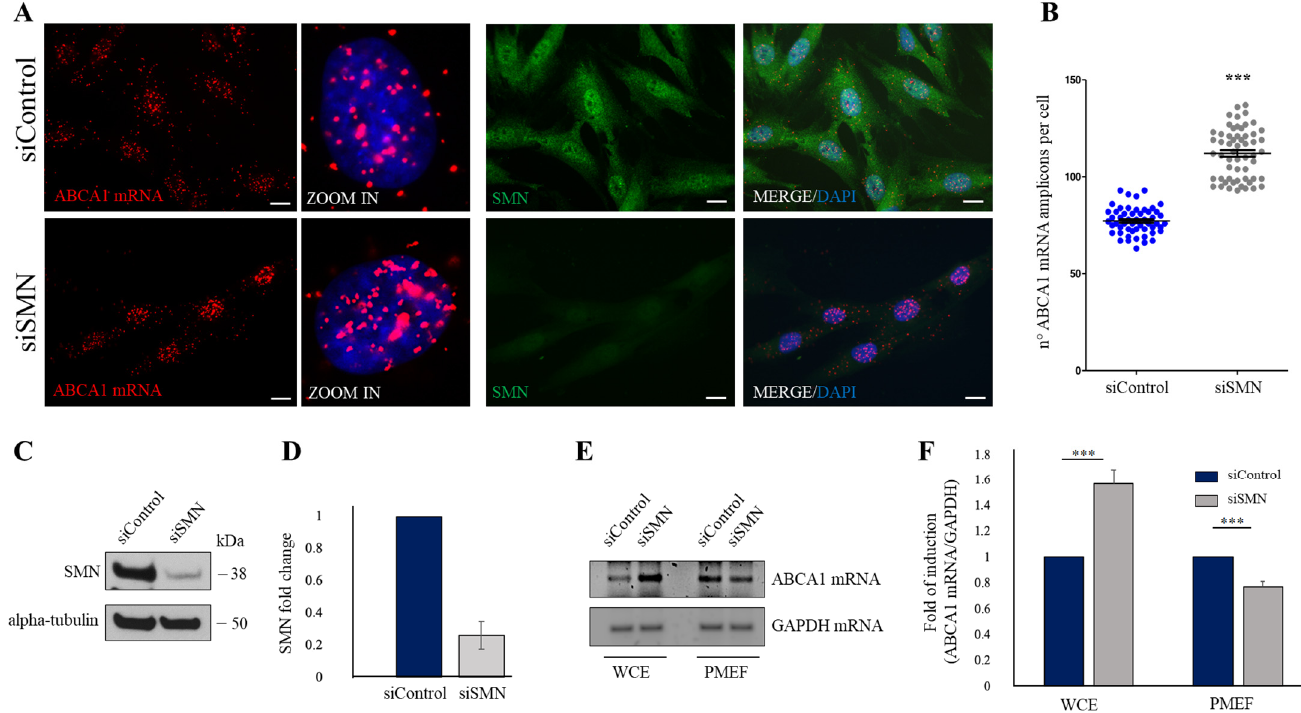
Figure 2. SMN knockdown affects the subcellular distribution of ABCA1 mRNA. ( A ) Padlock assay targeting ABCA1 mRNA (red dots). Images in ZOOM IN panels represent high magnifications of a selected cell. Nuclei were labelled with Dapi (blue). The combination of padlock assay targeting ABCA1 mRNA (red dots) and SMN immunostaining (green) was carried out in siControl- and siSMN-transfected human fibroblasts. Nuclei were stained with DAPI (blue). Scale bar, 10 µm. ( B ) Quantitative analysis of ABCA1 mRNA amplicons per cell (n = 20 cells were analyzed for each condition). Results from three independent experiments are plotted in the graph. Mean ± s.d. are illustrated. Asterisks indicate significant differences using unpaired t -test (*** p < 0.0001). ( C ) Western blot analysis validating SMN reduction in siSMN-transfected fibroblasts. Equal amounts of proteins were immunoblotted for the indicated antibodies. ( D ) Histogram indicates SMN fold change in siSMN-transfected fibroblasts compared to siControl, taken as 1. The means of three independent experiments are reported. Error bars represent s.d. ( E ) ABCA1 mRNA and glyceraldehyde-3-phosphate dehydrogenase (GAPDH) mRNA were checked in WCE and PMEF of siControl- and siSMN-transfected fibroblasts by semiquantitative RT-PCR, and analyzed by agarose gel electrophoresis. Panels are representative of three independent experiments. ( F ) Densitometric analysis of ABCA1 mRNA normalized to GAPDH mRNA in WCE and PMEF of siSMN-transfected fibroblasts compared with the control (siControl). The graph illustrates the means of three independent experiments. Error bars represent s.d. Asterisks indicate significant differences using unpaired t -test (*** p < 0.01). 2.3. SMN Deficiency Down-Regulates ABCA1 Protein Levels and Causes Intracellular Accumulation of Cholesterol Given the novel link between SMN and ABCA1 mRNA, we asked whether SMN could also influence expression levels of ABCA1 protein. Using Western blot analysis, we checked and compared ABCA1 protein content in siSMN- and siControl-transfected fibroblasts (Figure 3 A). Furthermore, since ABCA1 protein induction occurs in an ATP- dependent manner [26], we also monitored ABCA1 protein levels in cells stimulated by a standard ATP-depletion/recovery assay [9,29,30]. A band of approximately 254 kDa, corresponding to the molecular weight of ABCA1, was detected in unstimulated fibroblasts. In our system, ABCA1 protein appeared unchanged or slightly reduced in SMN-depleted cells, compared to control (Figure 3A,B, unstimulated). Interestingly, ATP- depletion/recovery stimulation caused an increase in ABCA1 protein, which was